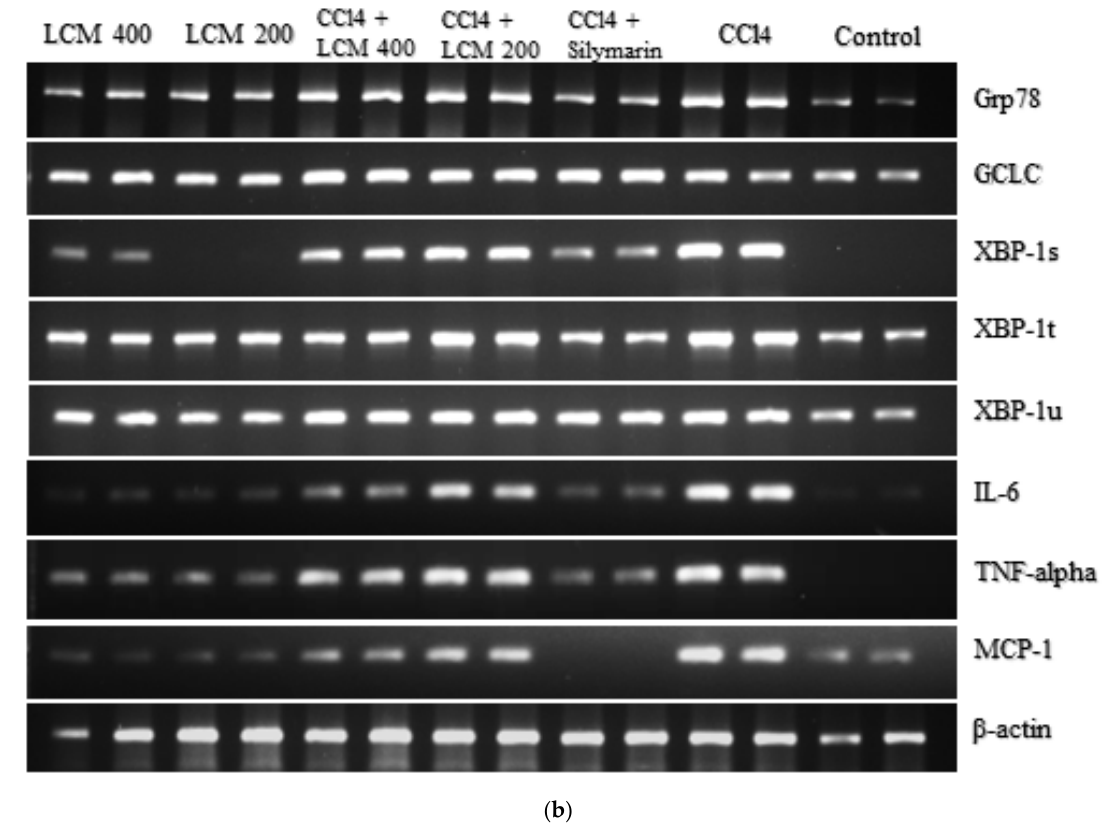
Figure 3. ( a ): Graphical representation of different treatments with LCM on fold changes of various genes involved in ER stress and inflammation.